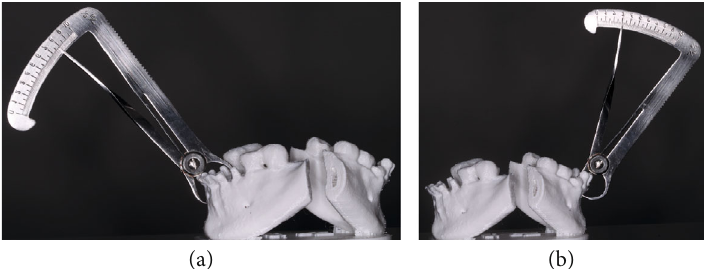
Figure 5: 3D resin prototype of the appearance of the ridge before (a) and after (b) the volume increase of the alveolar ridge. There was a 5mm gain in bone thickness.